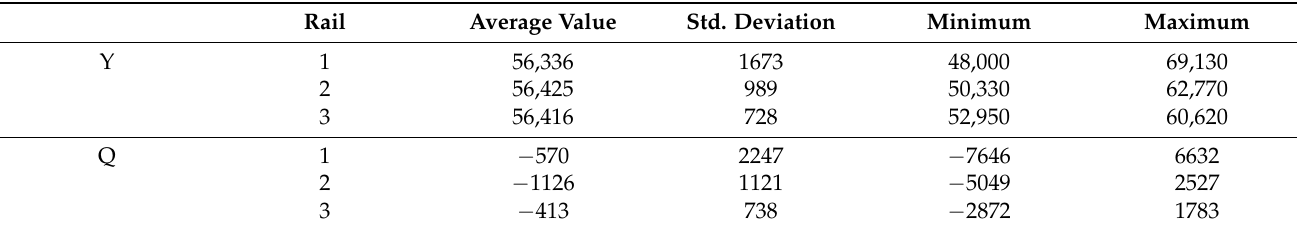
Table 5. A comparison of the basic statistical values of the vertical (Y) and lateral forces (Q) (in N) impacting the wheel for various rail profiles (assumed a nominal wheel